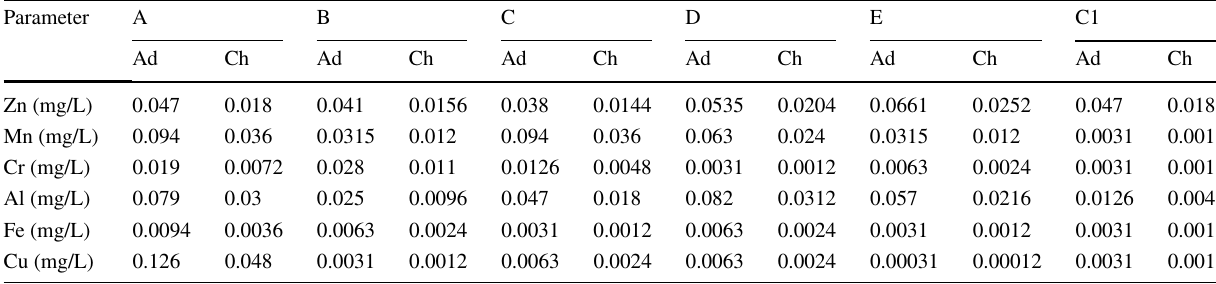
Table 4 Exposure dose (mg/kg/day) due to the intake of the